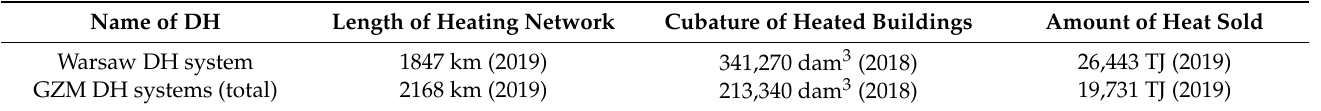
Table 1. Comparison of Warsaw DH system and aggregated data of GZM DH systems. Source: own elaboration based on [28–30].